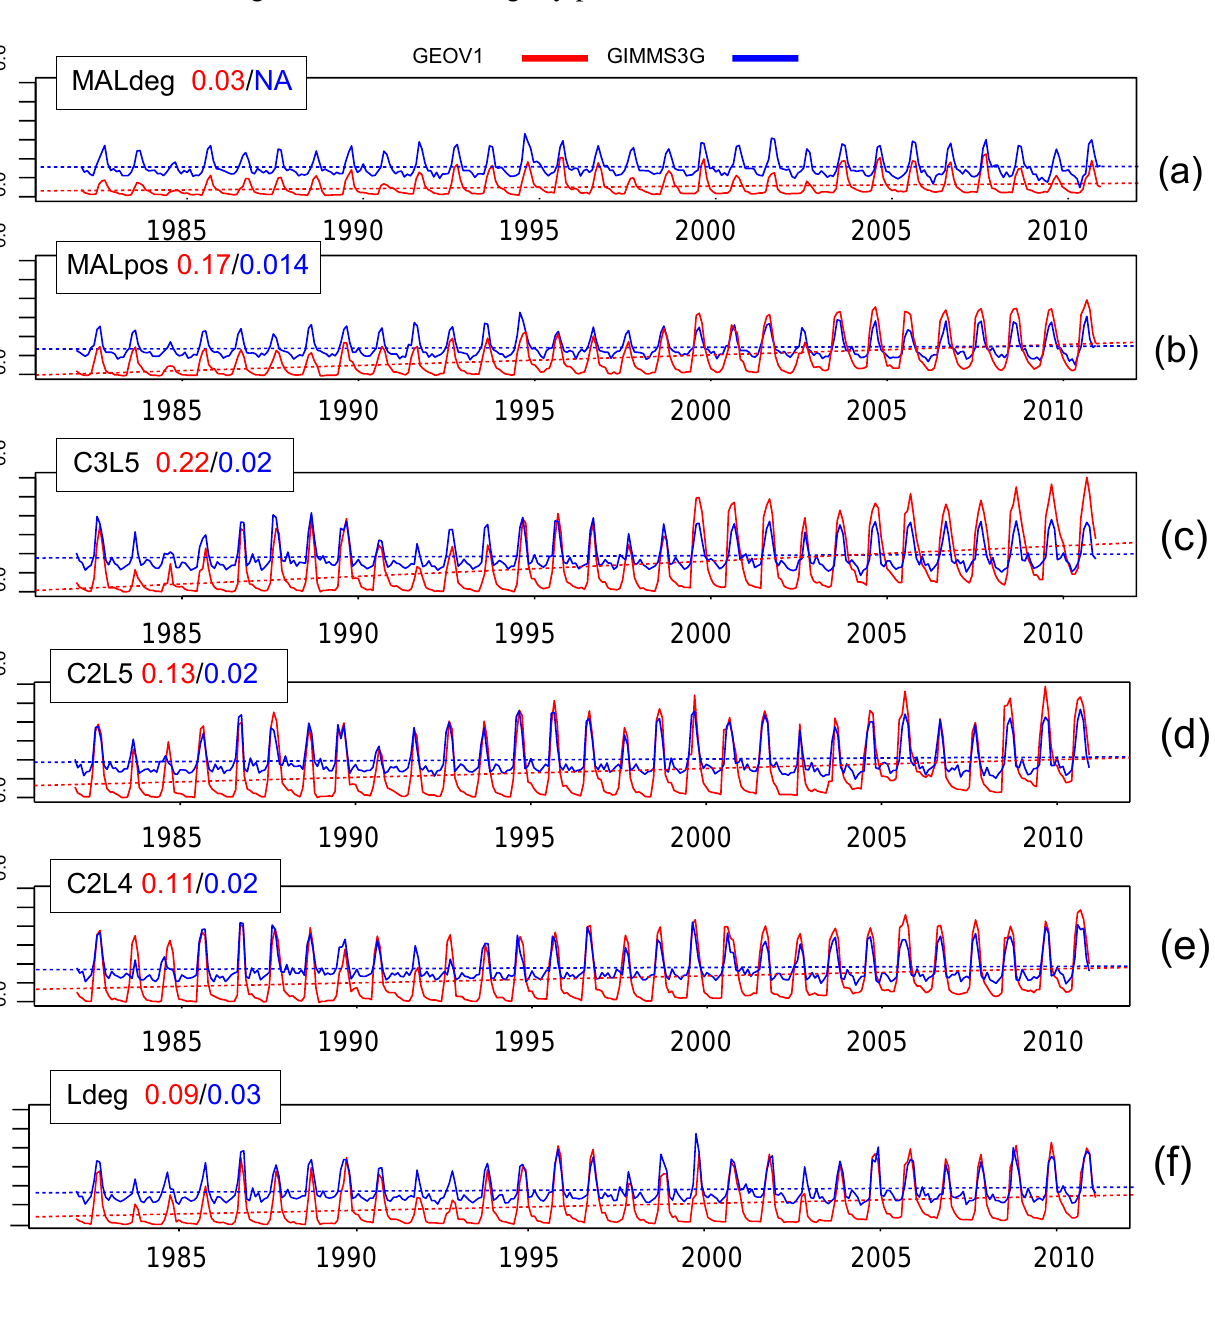
Figure 6. Temporal profiles extracted from the pixel overlaying two sites near Bandiagara ( a , b ) and four sites around Lingu`ere ( c – f ) from 1982 to 2010. The numbers (top left) indicate change in FAPAR units. Profiles (a) show a large degraded area, which is the reason for a very small positive trend in GEOV1 and insignificy in GIMMS3g, despite of increasing rainfall; Profiles (b) are extracted over onion plantations, which were established after the year 2000 and therefore a strong positive trend can be observed in GEOV1. Site C3L5 (c) reacts to rainfall changes and therefore had a strong positive trend in the past decade. Drought years (especially 1983 & 1984) and the related damage on vegetation are clearly visible. The open tree savannas (d,e) have a moderate positive trend. Drought years are tempered better than in all profiles with lateritic soils. Temporal profiles (f) show a largely deforested and degraded area with a slightly positive